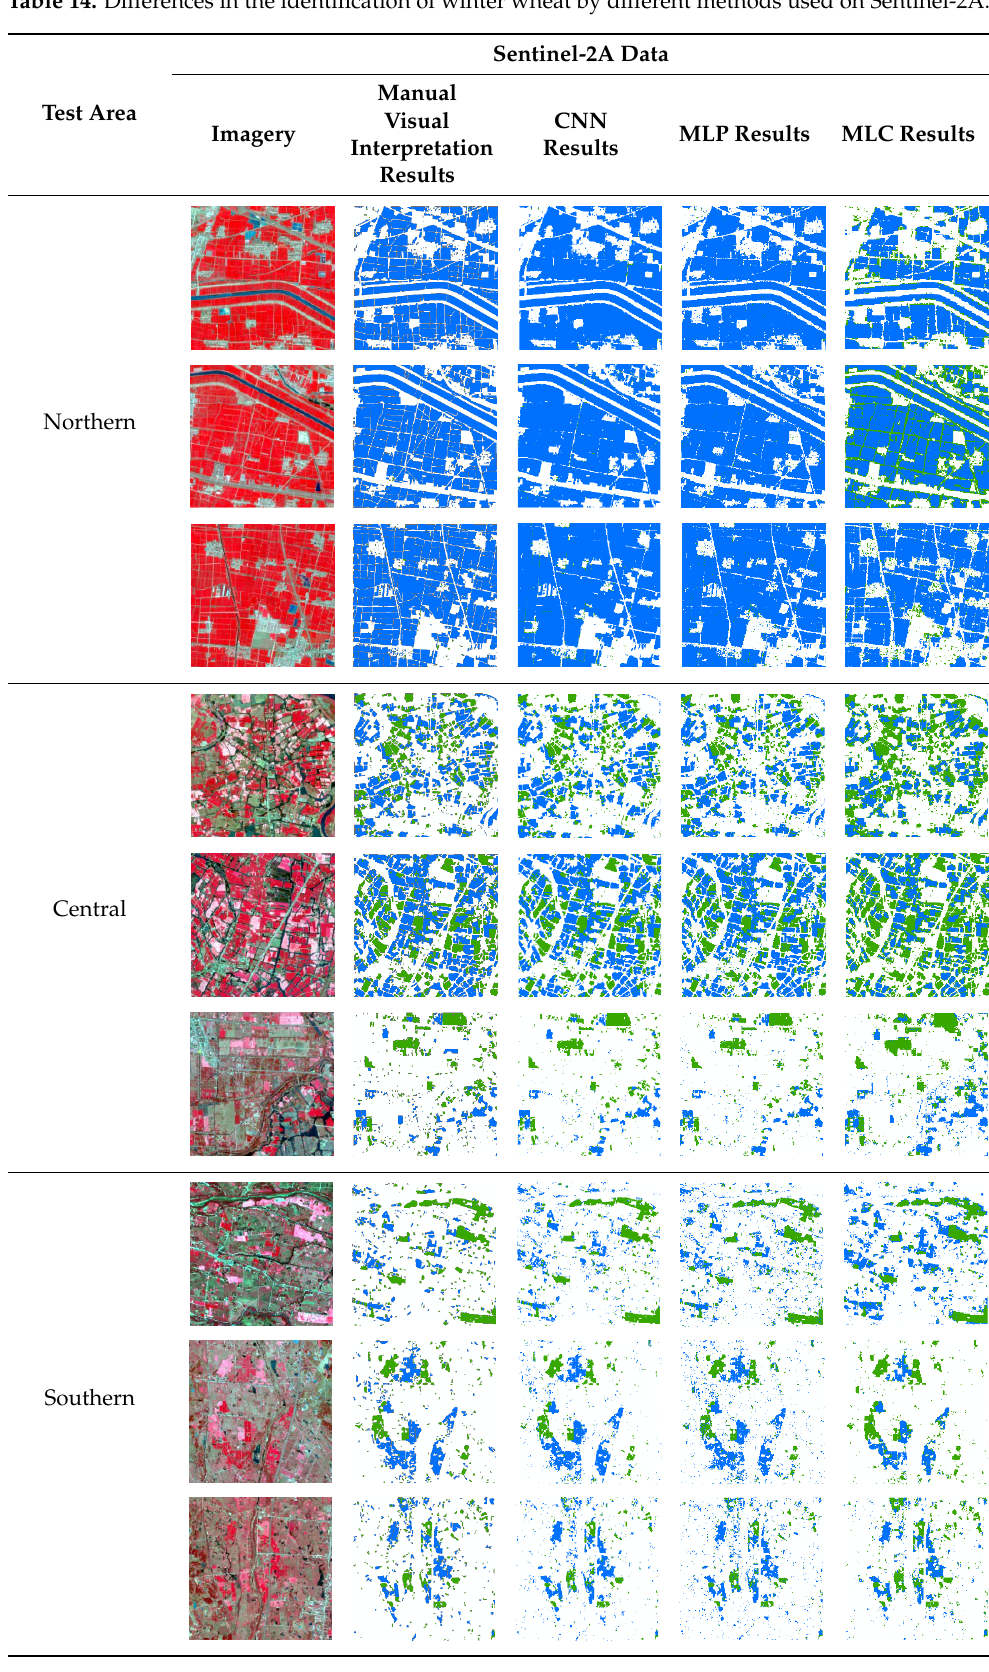
Table 15. Results of the correlation method to identify winter wheat on Sentinel-2A. Test Area